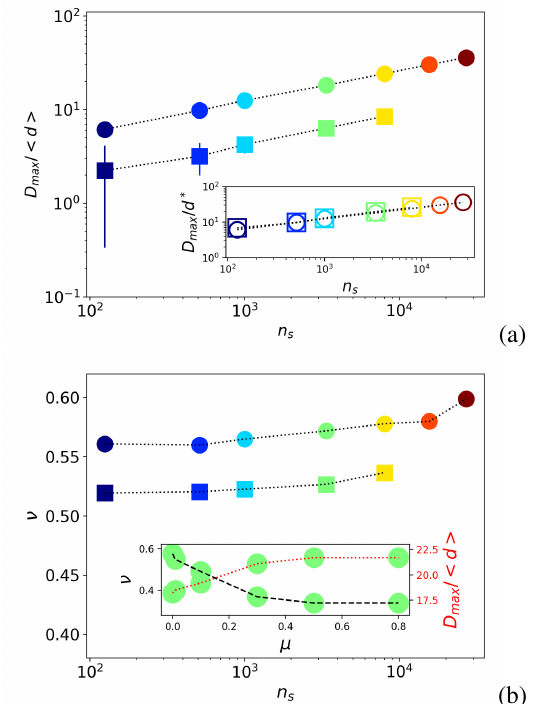
Figure 3. (a) Evolution of < E c > as a function of time at µ s = 0. The inset shows the variations of the maximal value of < E c > as a function of n s in assembly of spheres and polyhedra. Dif- ferent colors correspond to di ↵ erent particle numbers. (b) Z max as a function of n s averaged in the stabilized regime (i.e. for t > 125 min ) for frictionless assembly of polyhedra (square sym- bols) and spheres (disks symbols). The inset shows Z max as a function of µ for n s = 3375 in spherical particles.